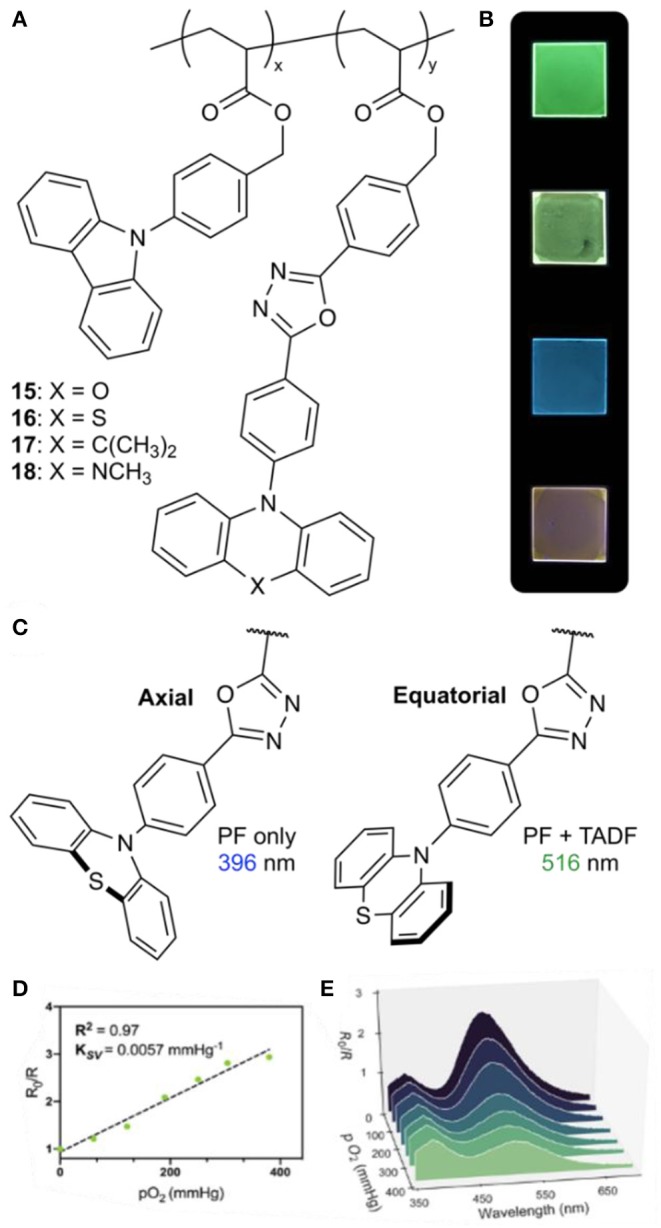
(A) Donor-acceptor TADF polymers; (B) films of 15–18 (from top to bottom); (C) illustration of pseudoaxial and pseudoequatorial conformers of phenothiazine and their respective emission wavelengths; (D) Stern-Volmer plot comparing the ratio of emission intensity at 516 nm to emission intensity at 396 nm (I516/I396) at various partial pressures of O2 for a film of 16; (E) fluorescence emission response of 16 to O2 concentration.